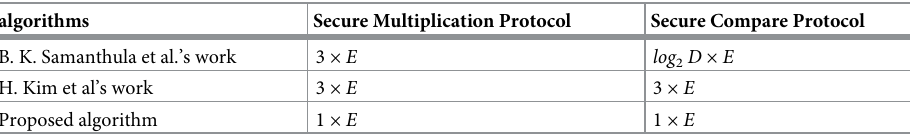
Table 3. A comparison of amount in secure